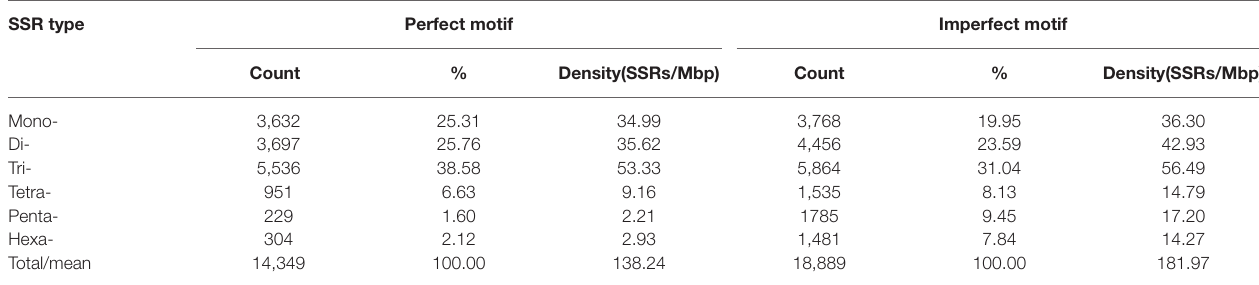
TABLE 4 | Variation in repeat length among genic cabbage perfect and imperfect